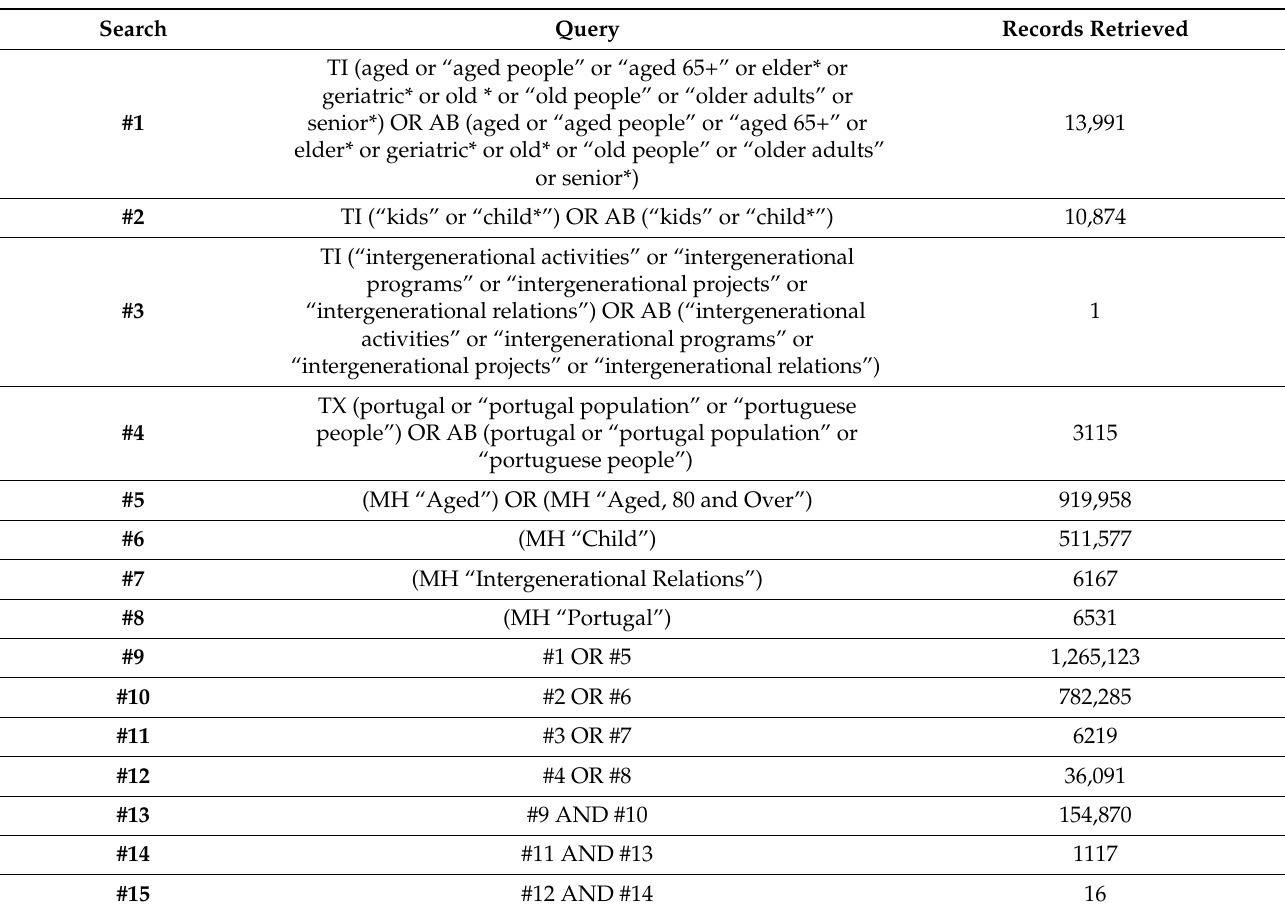
Table 1. The complete research strategy used in CINAHL